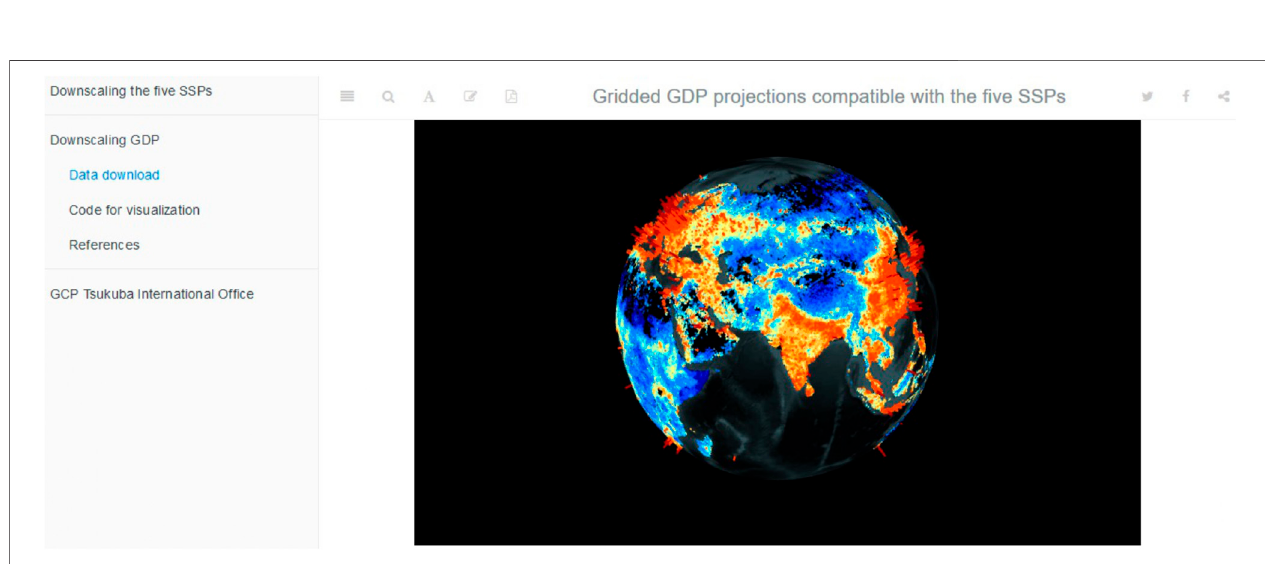
FIGURE 6 | Image of the website for GDP data